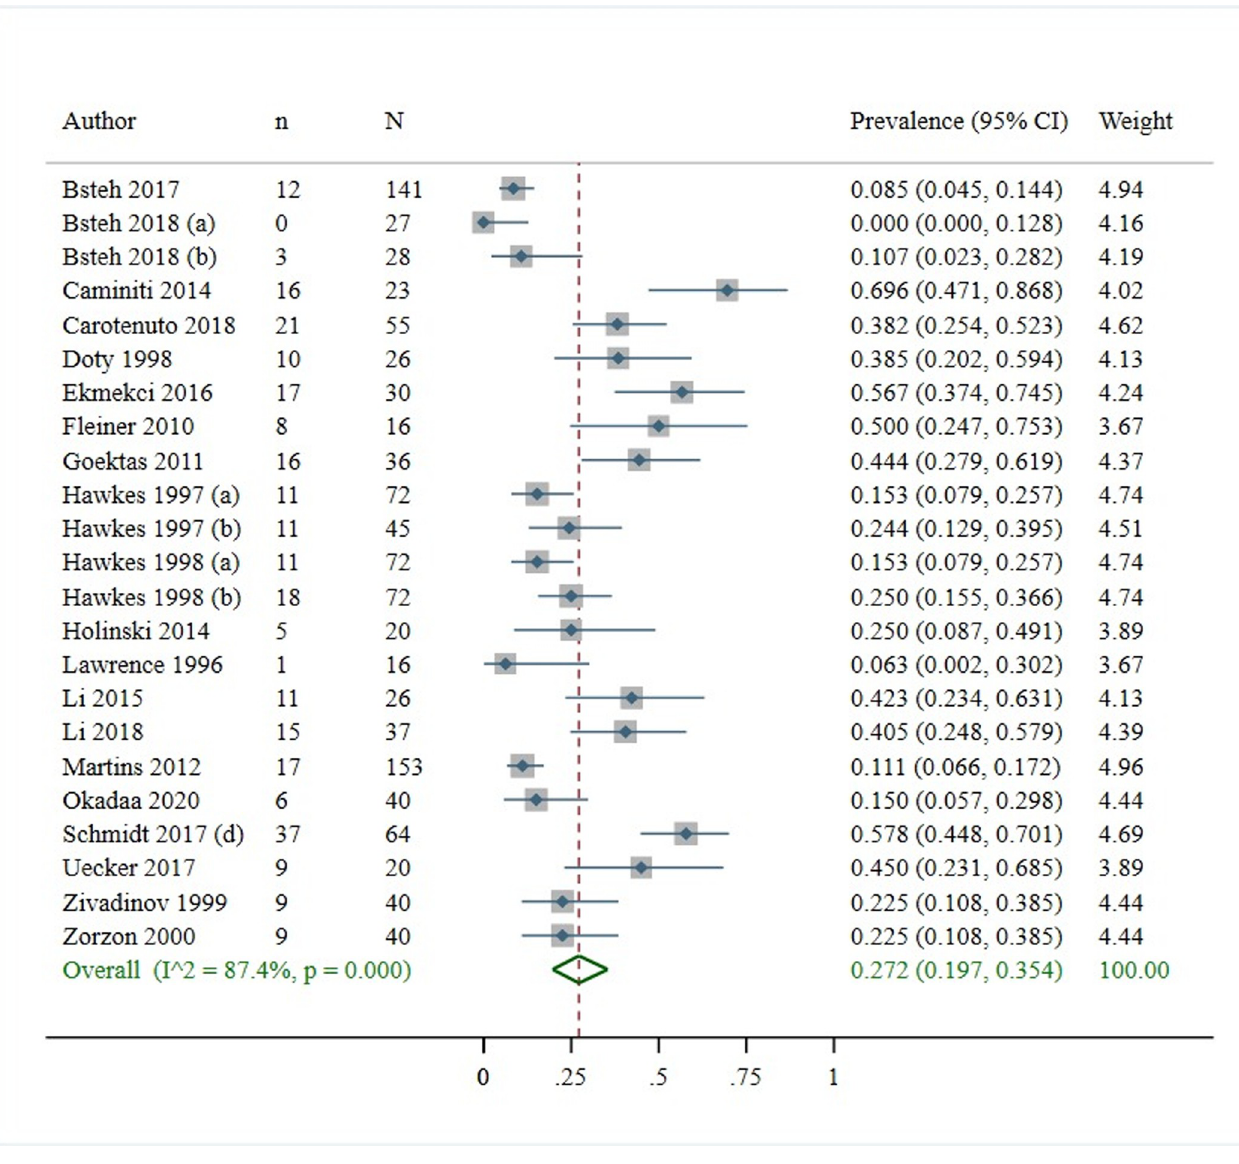
Fig 3. The pooled prevalence of olfactory among patients with